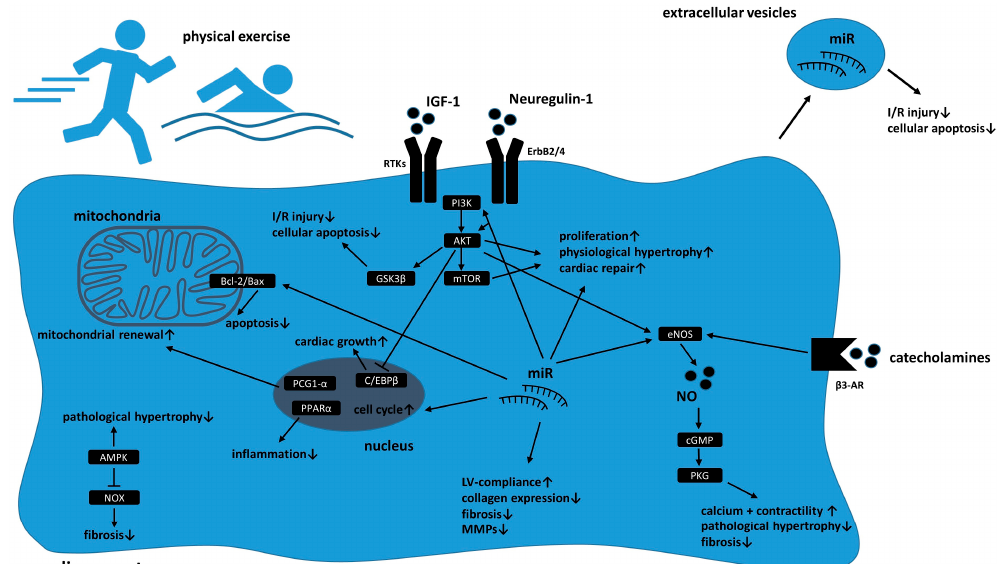
Figure 1. Schematic overview of cellular reprogramming in cardiomyocytes in response to physical exercise. Activation of receptor tyrosine kinases (RTKs) such as ErbB2/4 via growth factors (e.g. insulin-like growth factor 1 (IGF-1) or Neuregulin-1) enhance phosphatidylinositol 3 phosphate kinase (PI3K)/protein kinase B (Akt)/mammalian target of rapamycin (mTor)/ glycogen synthase